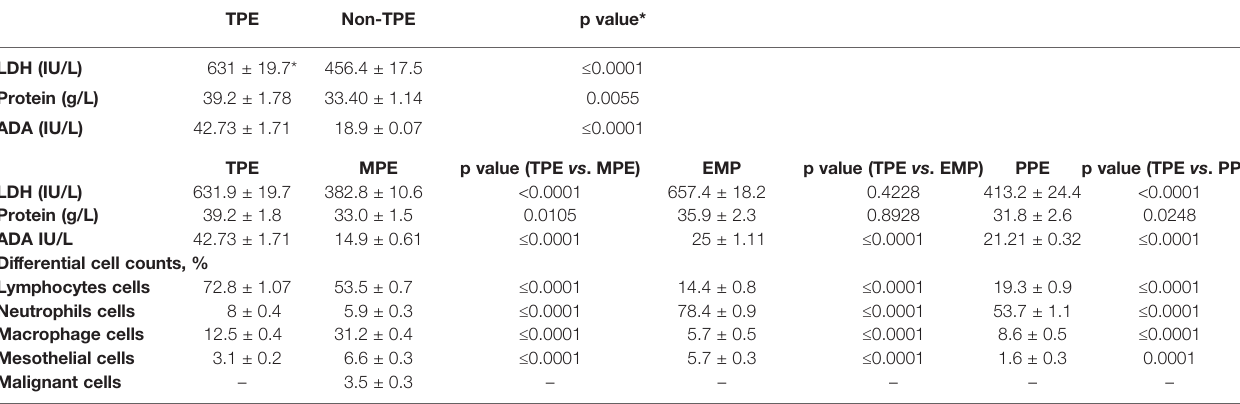
TABLE 2 | Biochemical and cytological characteristics of pleural